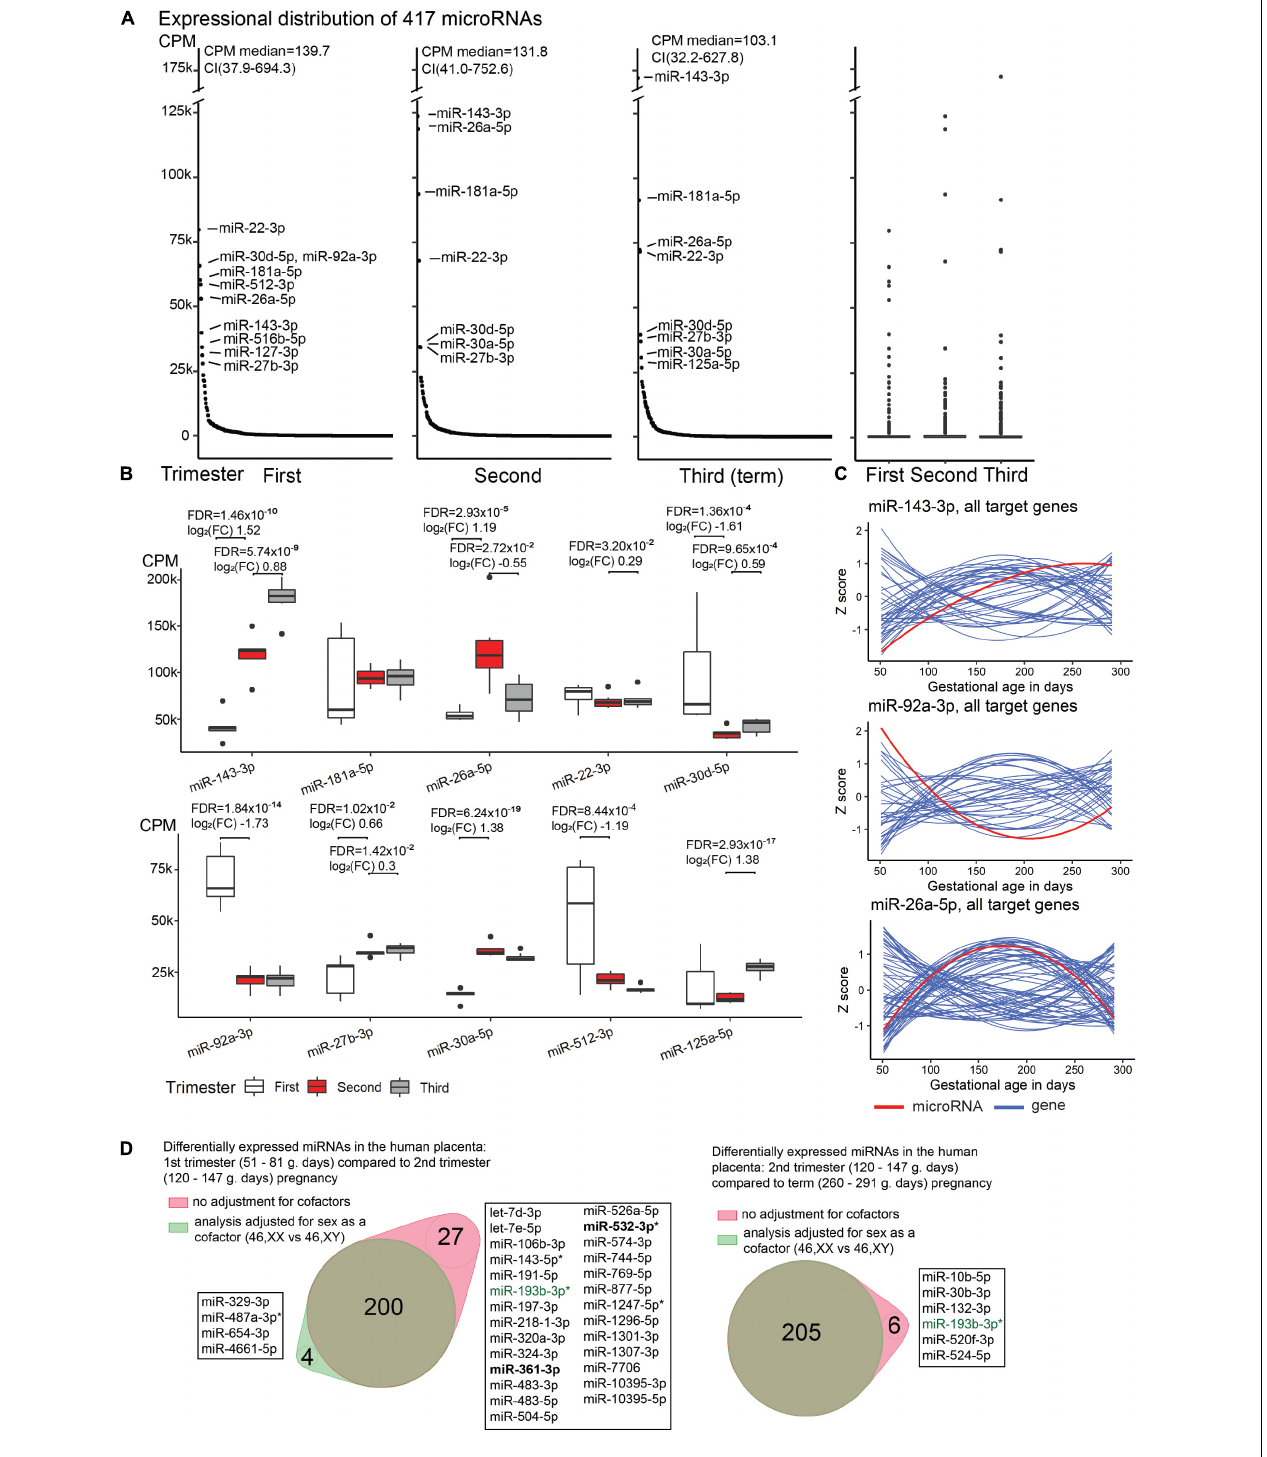
FIGURE 1 | Expressional distribution of placental miRNome. (A) Transcript levels of the analyzed 417 miRNAs in the first (median 60; range 51–81 g.days) and second trimester (121; 108–140 g.days) and term placental samples (284; 260–291 g.days). miRNA expression was quantified in counts per million reads mapped (CPM). Highly expressed miRNAs (CPM > 25,000) are indicated. Full details are provided in Supplementary Table 1 . (B) Trimester-specific expression levels of placental miRNAs with the highest transcript levels. Differential expression testing between the three trimesters of pregnancy was implemented in DESeq2 (ver. 1.22.2) (Love et al., 2014) package for R with default settings. Log 2 (FC), log 2 fold change in CPM; FDR, false discovery rate, calculated based